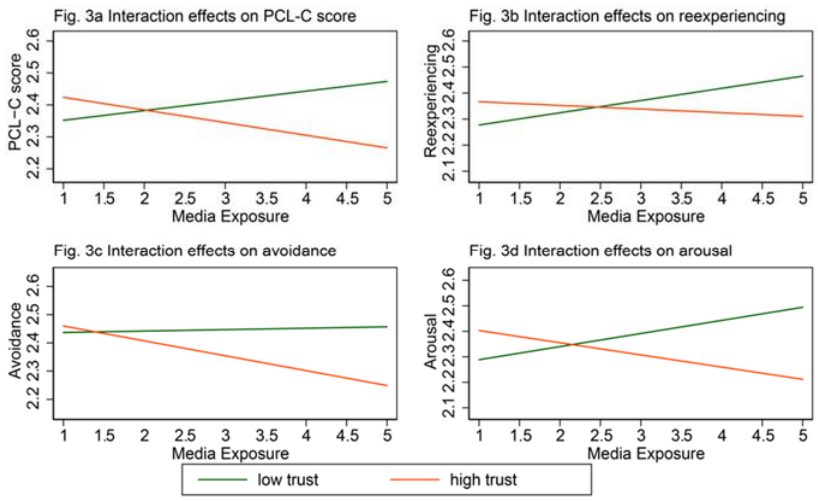
Figure 3. Interaction effects of media exposure and general trust on PTSD symptoms.